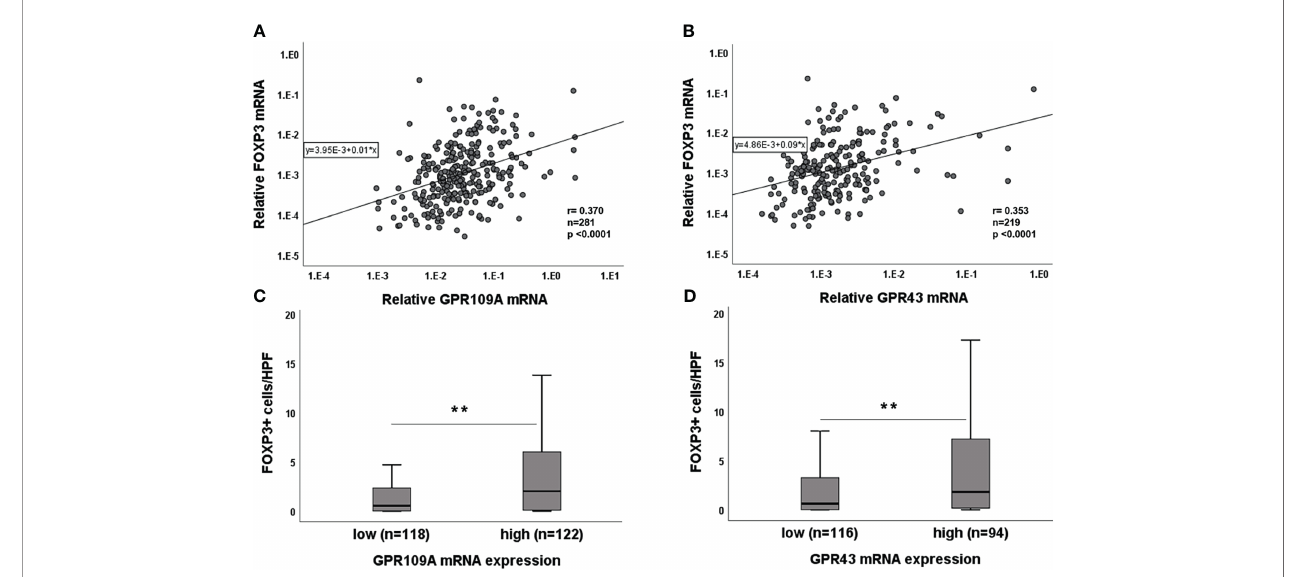
FIGURE 4 | Association of GPR with FOXP3 expression. Correlation of (A) GPR109A and (B) GPR43 with FOXP3 mRNA. Association of (C) GPR109A and (D) GPR43 with FOXP3 cellular in fi ltrates. **p < 0.01, Mann-Whitney U test; r value, Spearman